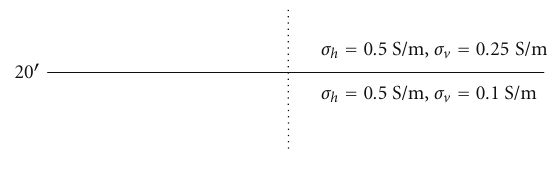
Figure 19: A two-layer anisotropic formation.